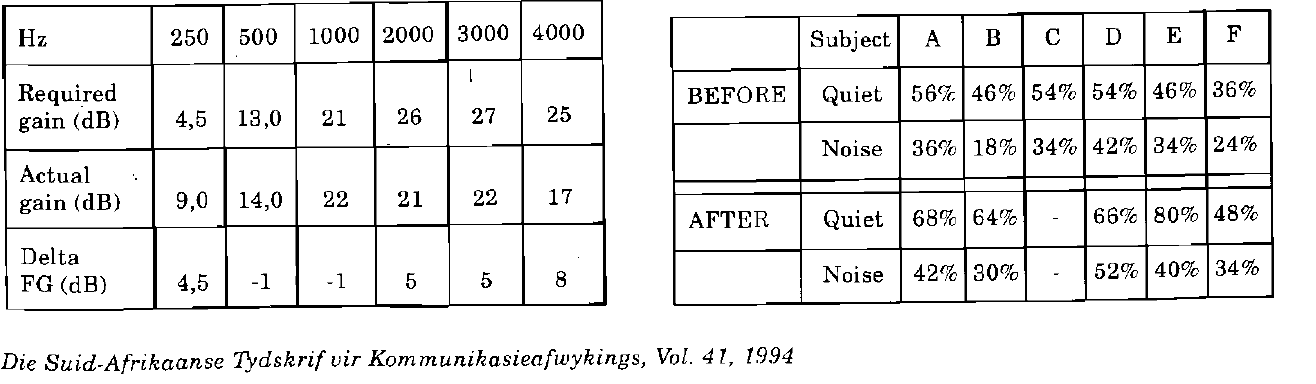
Table 3. The aided mean of ideal and actual func- tional gain at each frequency, and the difference between them after modification.